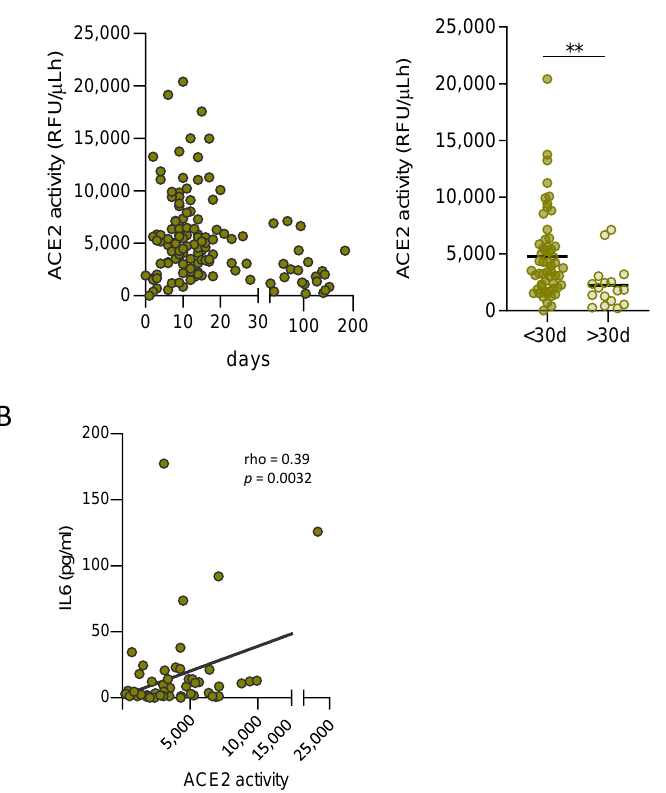
Figure 3. Soluble ACE2 plasma levels in COVID-19 patients. ( A ) Left, ACE2 enzymatic activity in plasma samples from SARS-CoV-2 positive subjects ( n = 75), collected at different days from diagnosis. Right, soluble active ACE2 levels stratified by time of sampling. ( B ) Positive correlation of IL6 plasma levels and plasma ACE2 activity ( n = 54). Data are shown as mean ± SEM and analyzed by Mann-Whitney U test, ** p < 0.01. Linear correlation (Spearman) r and p -values are